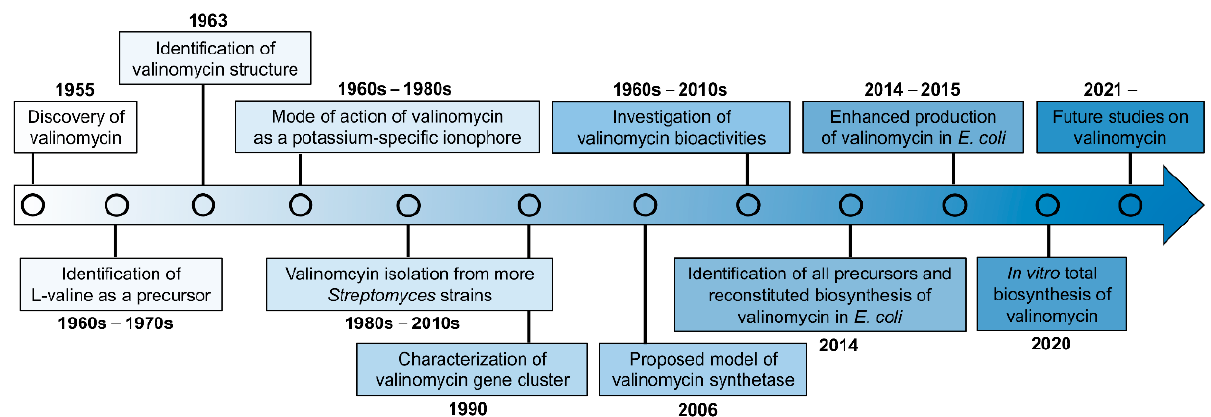
Figure 2. The timeline of valinomycin